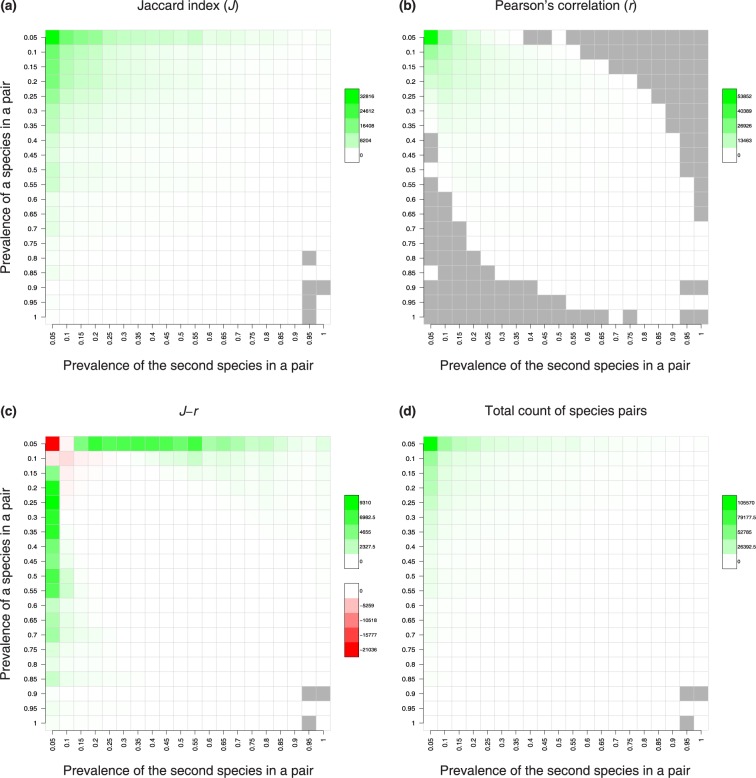
Number of species pairs identified as significant by J and r as a function of species prevalence.The prevalence of two species in a given pair are shown on the two axes of the grids. After binning the prevalence at 5% interval, the total number of pairs significant in each grid cell was counted. Color scale across plots does not match; gray cell indicate lack of species pairs. Both J (a) and r (b) detect many species pairs significantly correlated (all positive) when at least one of the species in the pair is rare. However, when one of the species is abundant, unlike J, r fails to detect significant pairs (b). The difference in the number of species pairs significant for J and r shows a strong pattern with species prevalence (c). Total number of species pairs in the species prevalence grid is shown in (d). Of 844350 species pairs, 627539 (74.3%) have at least one of the species in the pair very rare (<10% prevalence) whereas 205120 (24.3%) have both species very rare.